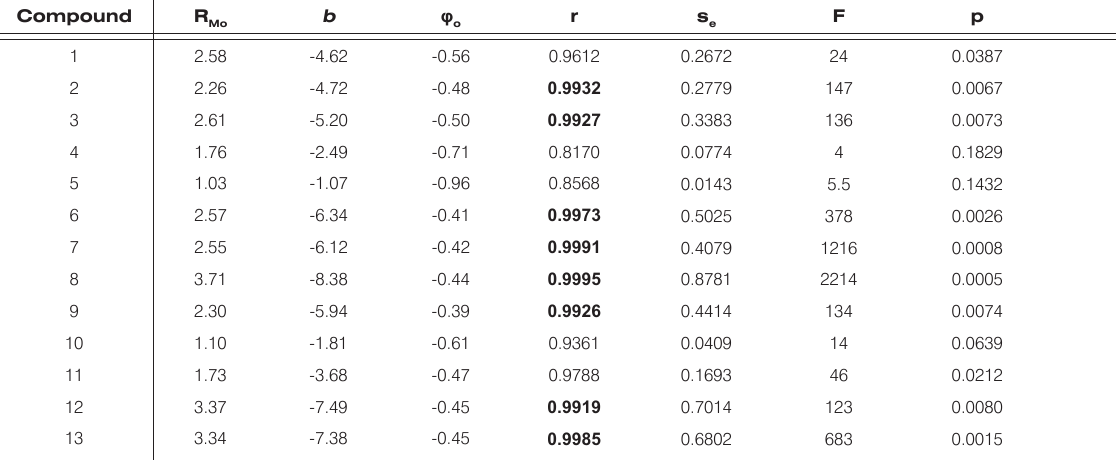
Table 2. Statistical regression data of the compounds (values greater than 0.99 are bolded) Compound R